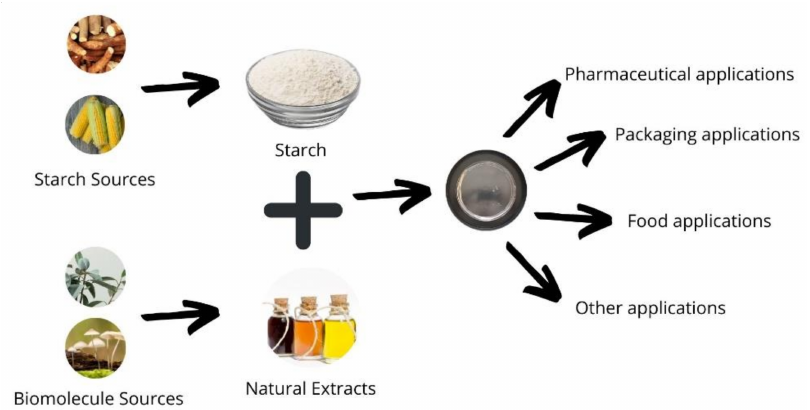
Figure 2. Schematic representation of starch and sources of natural extracts and potential applications. Figures obtained from canva.com (accessed on 25 April